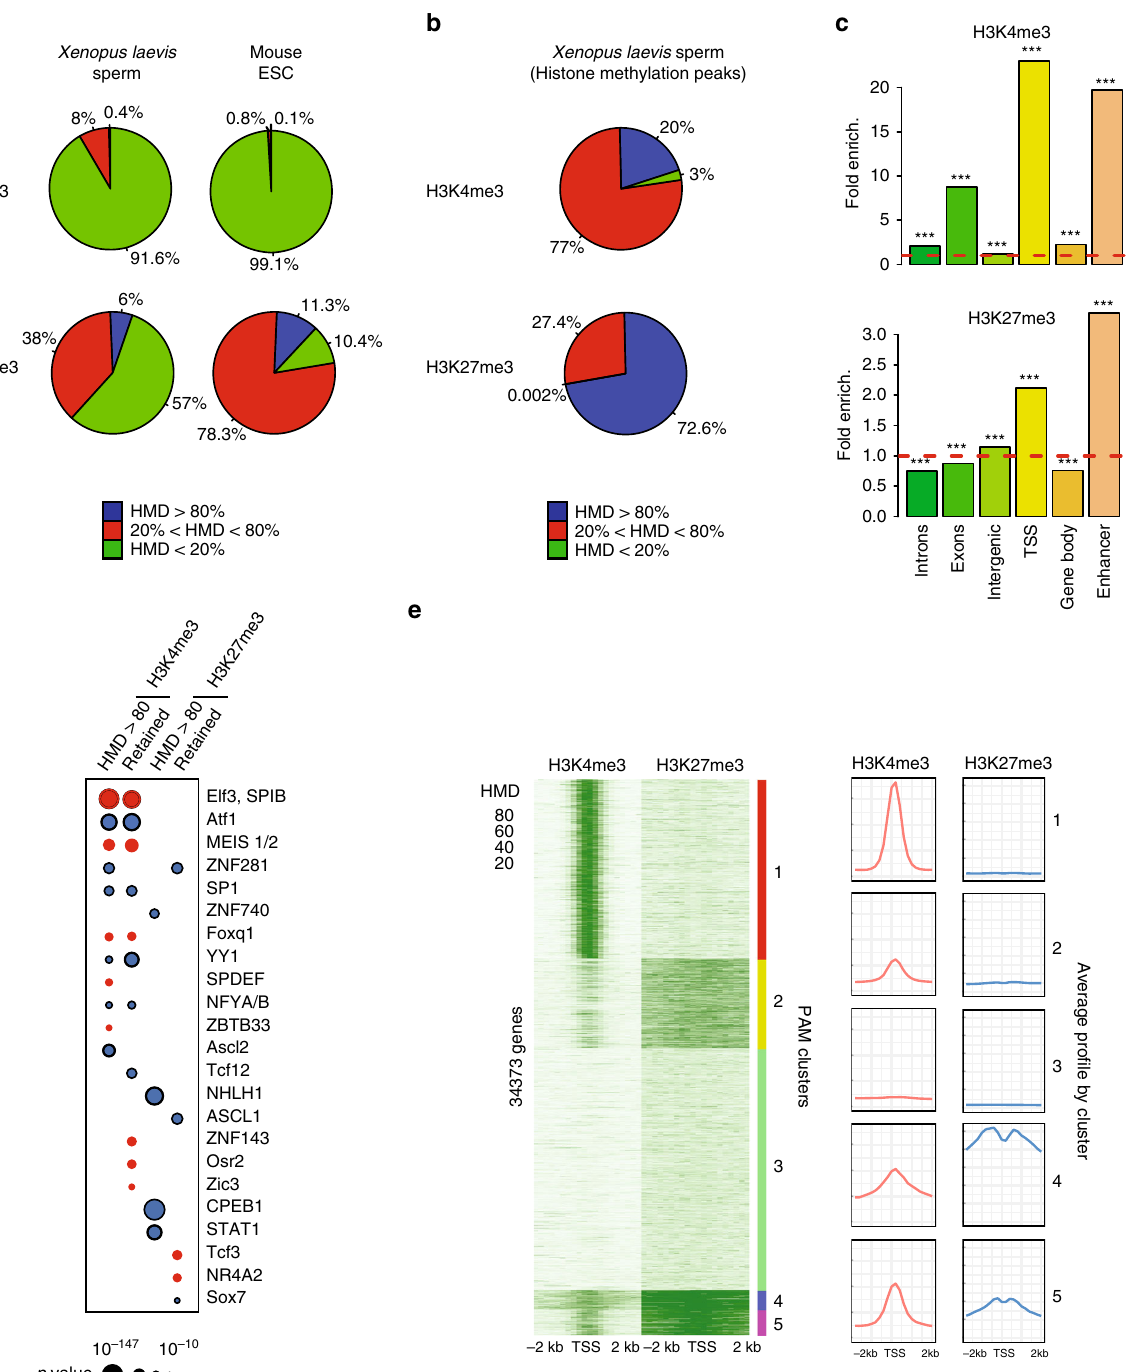
Fig. 3 A fraction of the genome harbours methylated H3K4 and/or H3K27 at the same location in most sperm of a population. a Percentage of the genome with different range of apparent histone H3 methylation density (HMD) on Lysine 4 and 27 in Xenopus Laevis sperm and mouse ESC. b Percentage of H3K4me3 and H3K27me3 peaks with different range of HMD in Xenopus Laevis sperm. c Fold enrichment (observed/random) over 1000 randomisations of peaks with homogeneous histone methylation (HMD > 80) at the indicated genomic features; ***: empirical p value < 1e − 3. ICe-ChIP data from two independent replicates were pooled. d Dot matrix showing transcription factors with enriched motifs ( y -axis) in the different histone methylation categories ( x -axis). Circle size represents – log10 ( p value) of the motif enrichment; and the circle colour indicates whether evidences exist indicating that the corresponding transcription factors is present maternally (blue) or not (red). Retained HMD > 80 peaks correspond to sperm histone methylation peaks maintained after extract treatment as in Fig. 5. e Heat map after PAM clustering of promoters (TSS + / − 2 kb) according to histone H3-methylation density on Lysine 4 and 27. The plots on the left show the average HMD pro fi le for each cluster. Source data related to a , b , d , and e are provided as Source Data fi